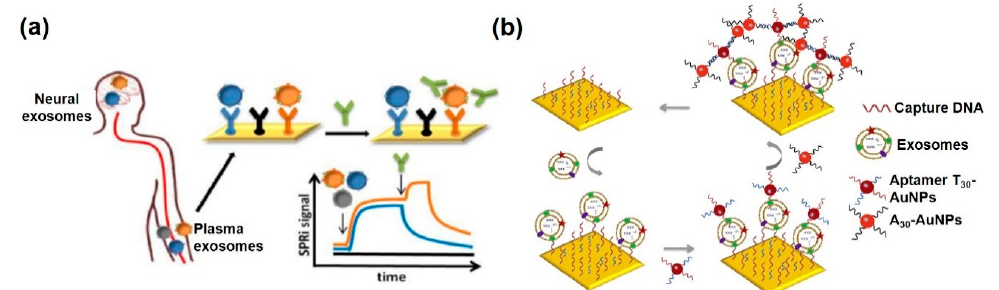
Figure 7. PSPR-based immunosensors for extracellular vesicle detection. ( a ) Detection and PSPR-based immunosensors for extracellular vesicle detection. ( a ) Detection